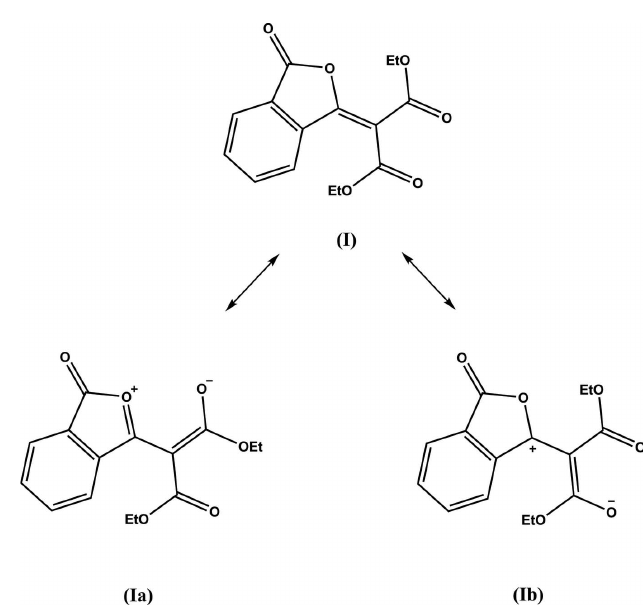
Figure 1 The molecular structure of ( I ), showing displacement ellipsoids drawn at the 50% probability level.